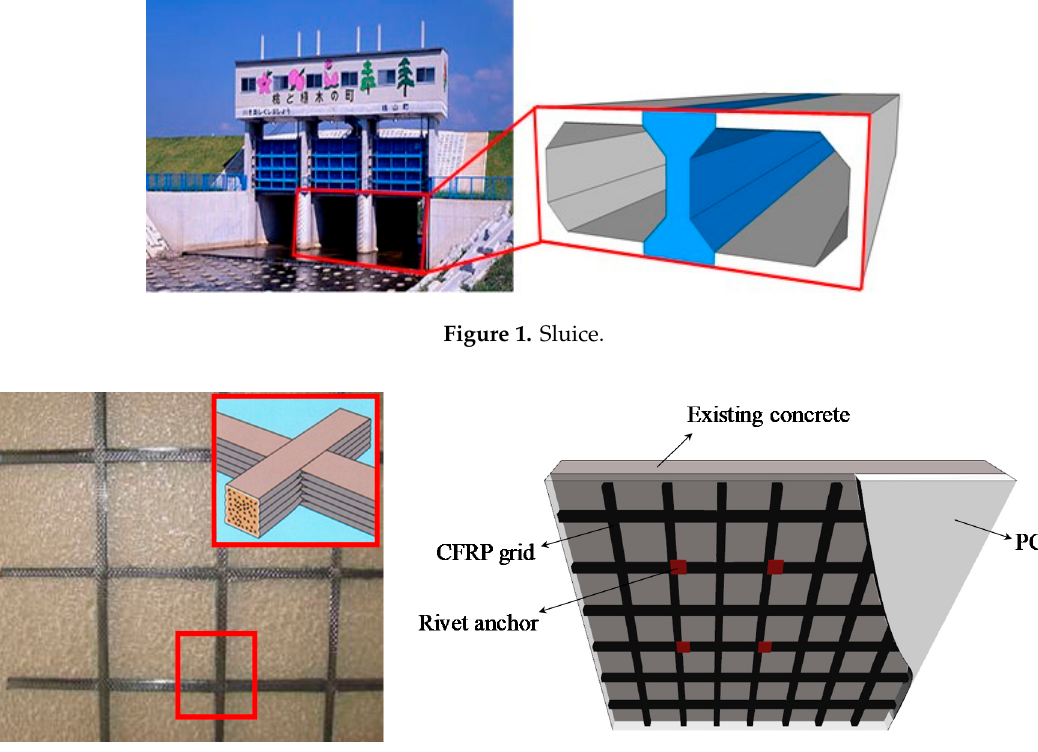
Figure 2. Carbon fiber reinforced polymer (CFRP) grid and schematic illustration of the strengthening method.